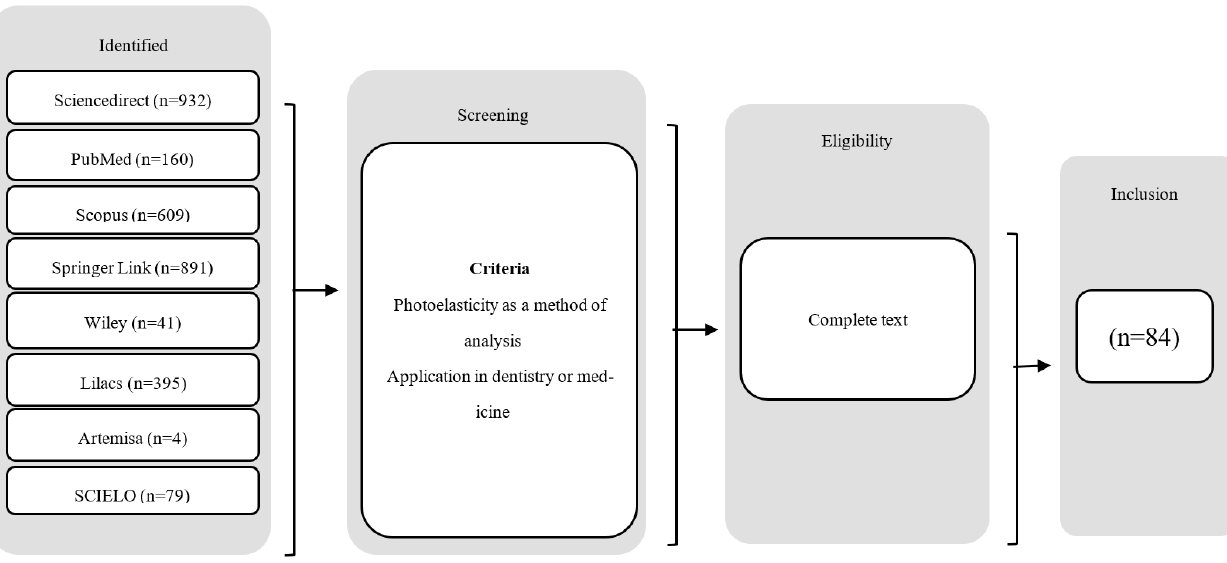
Figure 2. Selection process of published papers.